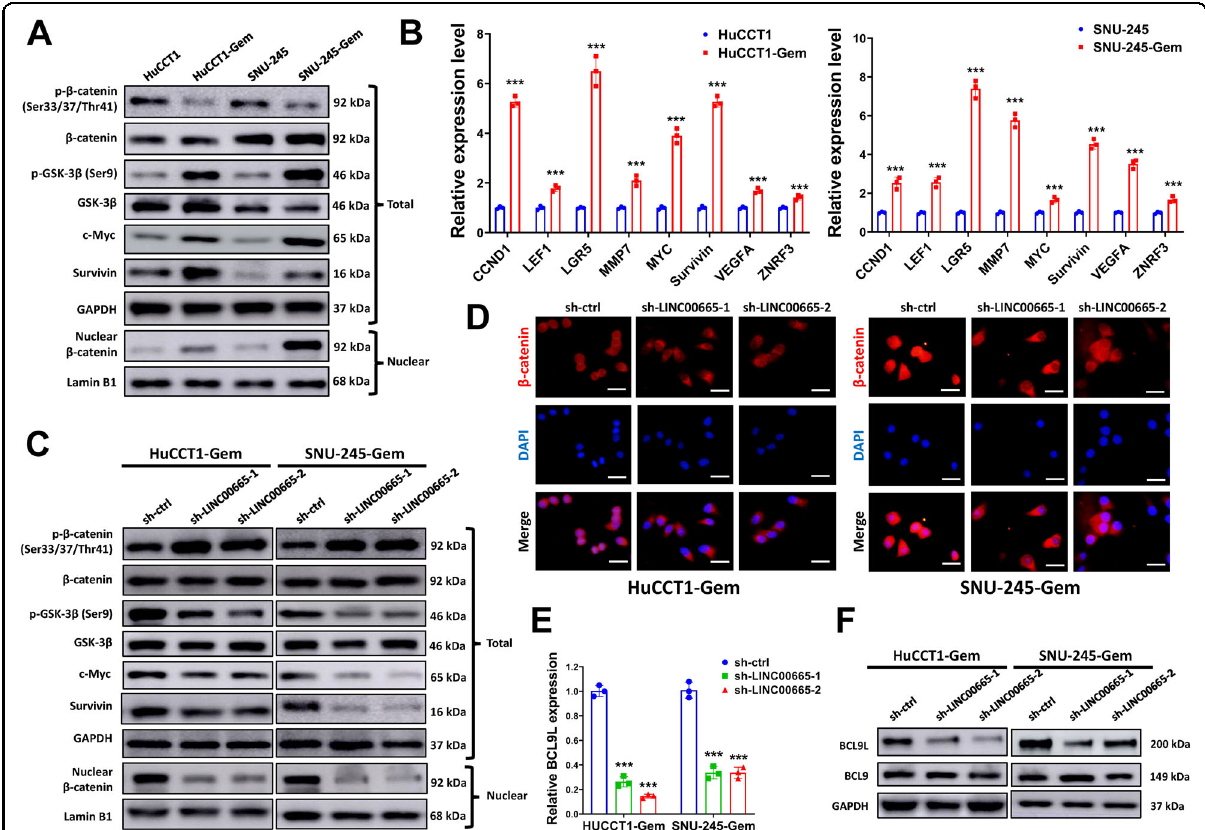
Fig. 5 Silencing LINC00665 represses Wnt/ β -Catenin signaling and BCL9L expression in gemcitabine-resistant CCA cells. A , B expression of indicated genes in Wnt/ β -Catenin pathway ( A ) downstream targets ( B ) was evaluated by western blot or qRT-PCR. C HuCCT1-Gem and SNU-245- Gem cells were transduced with sh-LINC00665-1, sh-LINC00665-2, or sh-ctrl, then the expression of indicated genes in Wnt/ β -Catenin pathway was evaluated by western blot. D immuno fl uorescent staining showed the subcellular location of β -Catenin in HuCCT1-Gem and SNU-245-Gem cells after transducing with sh-LINC00665-1, sh-LINC00665-2, or sh-ctrl. DAPI was used to stain the nucleus. Scale bars = 50 μ m. E , F expression of BCL9L in HuCCT1-Gem and SNU-245-Gem cells transduced with sh-LINC00665-1, sh-LINC00665-2, or sh-ctrl was evaluated by qRT-PCR ( E ) and western blot ( F ). *** P ≤